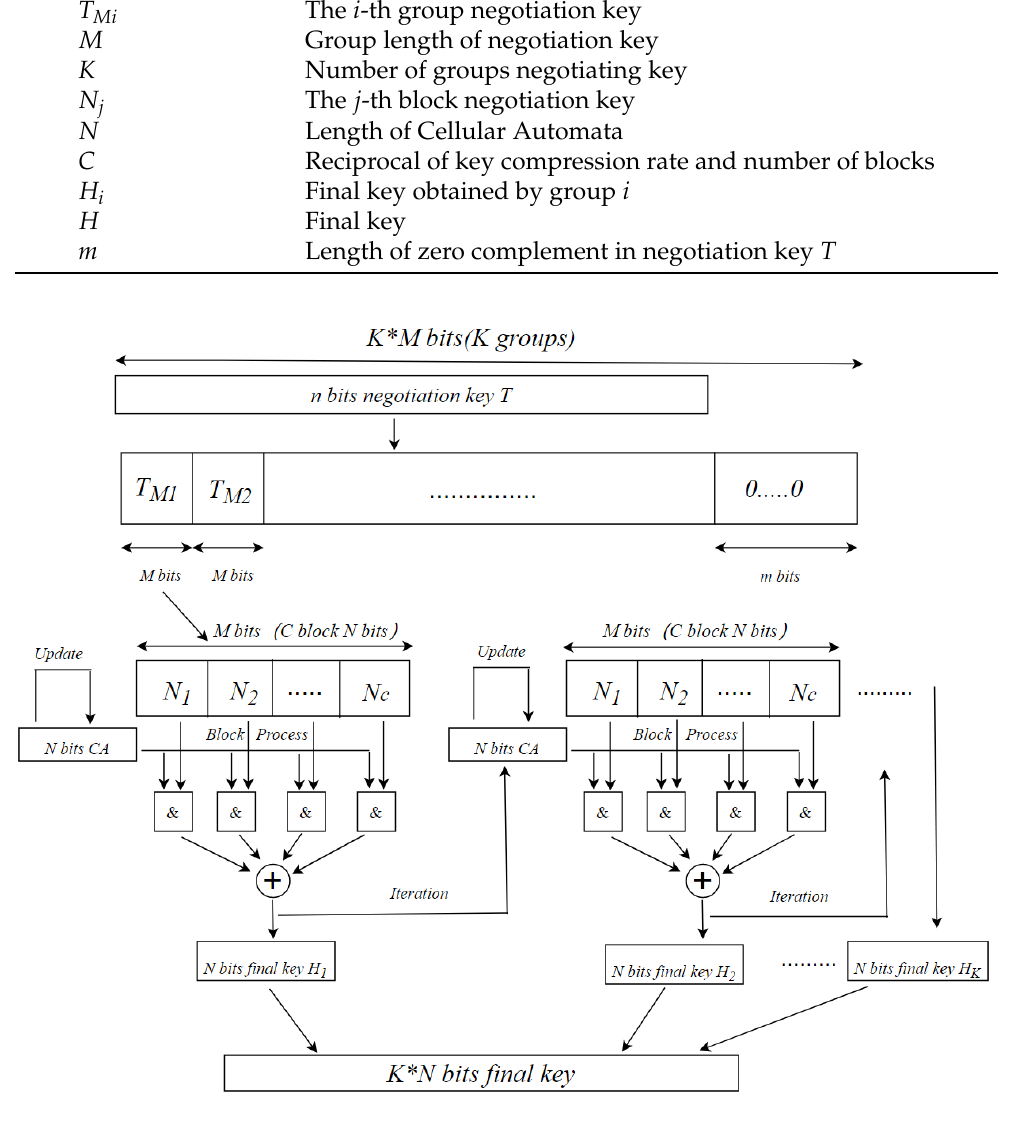
Figure 2. Schematic diagram of PA